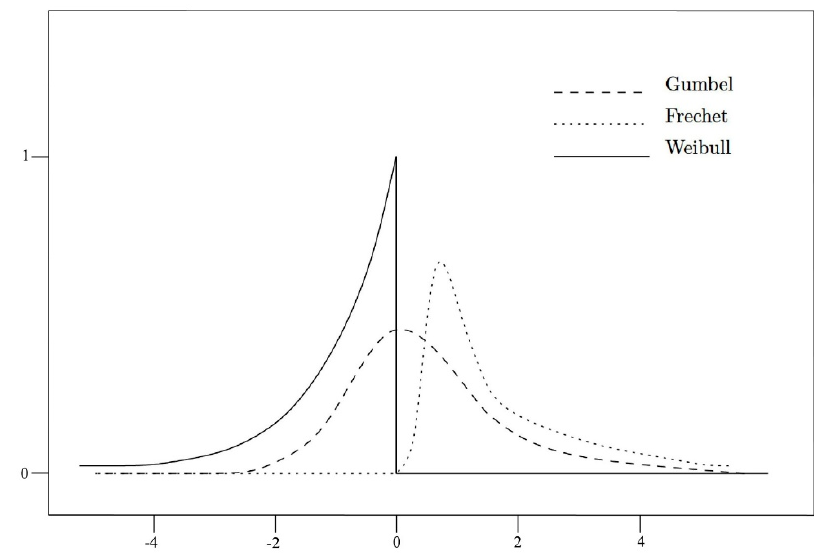
Figure 2. Densities of the standard extreme value distribution (cid:2009) = 1 .